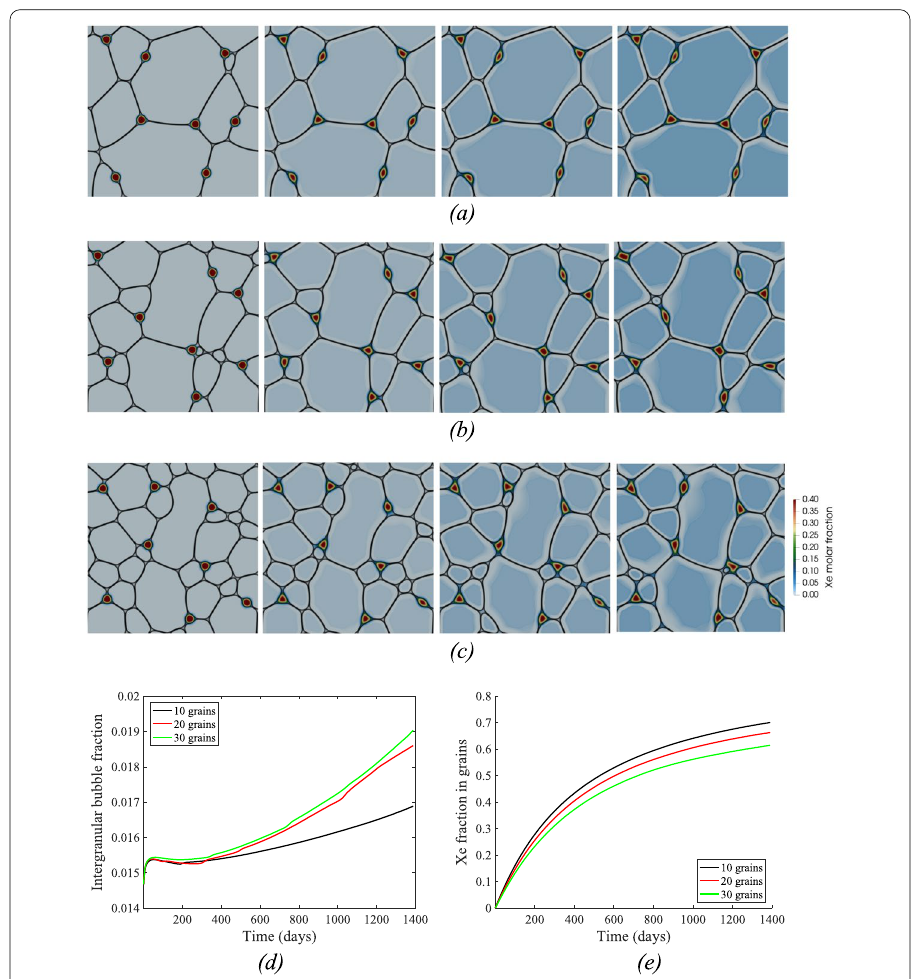
Fig. 10 The impact of initial grain on the fission gas behavior in a 20 μm 20 μm 2D polycrystal of UO 2 at × 1800 K with clustering and re‑solution. The evolution of the grain structure and fission gas concentration over time are shown for the ten, twenty, and thirty grain cases in ( a ), ( b ), and ( c ), respectively. The four images correspond to t 0, 336, 897, and 1389 days, from left to right. The evolution of the intergranular bubble = fraction over time for the three cases is shown in ( d ). The fraction of Xe found within the grains over time for the three cases is shown in (